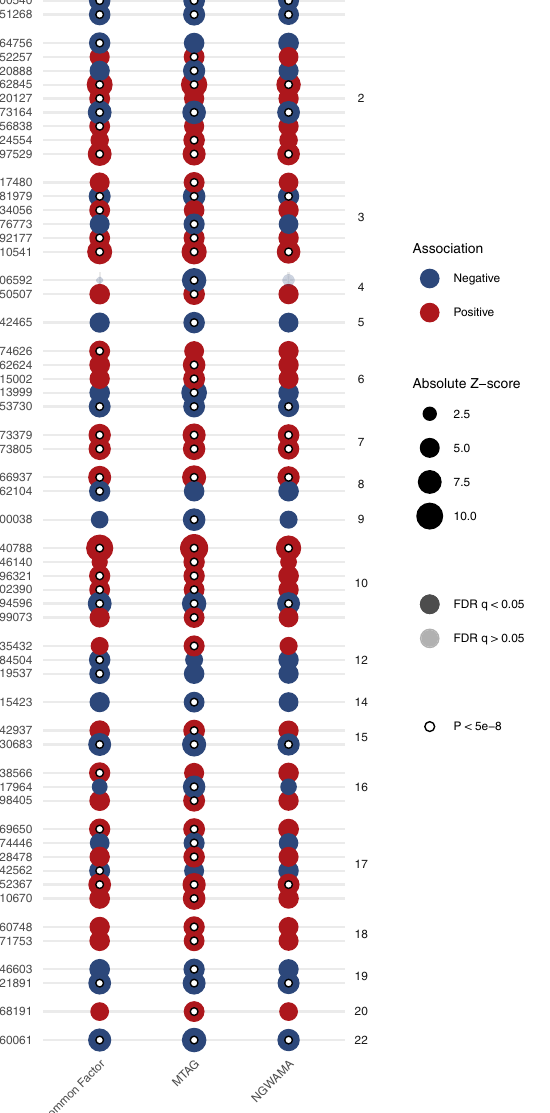
endocrine tissues.